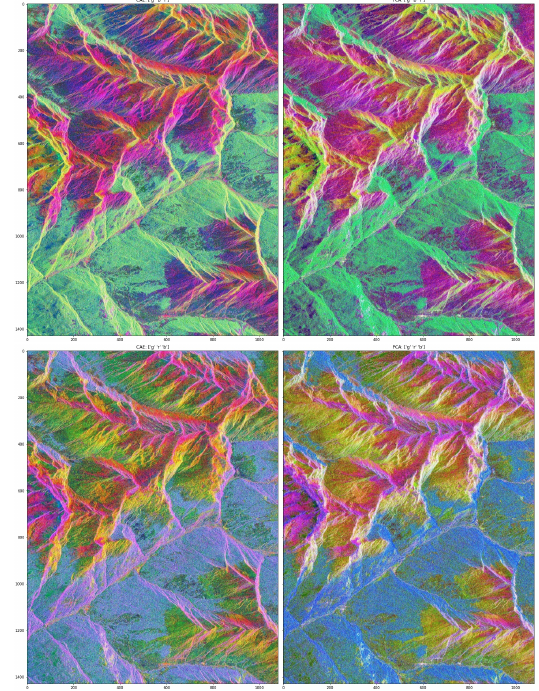
Figure 6. Resulting visualization schemes obtained with CAE (left) and PCA (right)